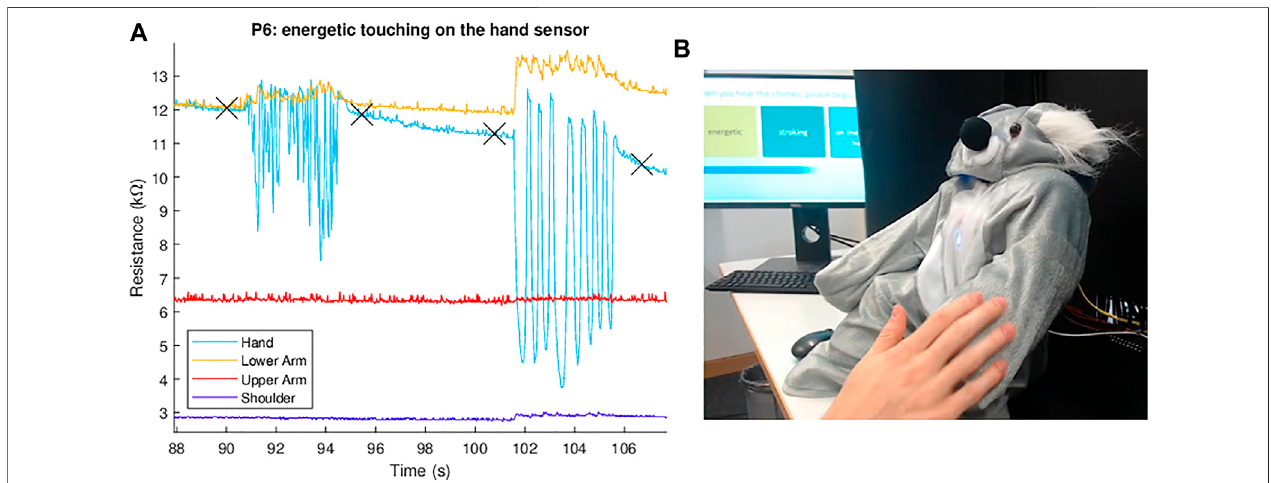
FIGURE3| Real-timesensorreadingsshowhowthefoursensorresistancevalueschange (A) astheparticipantinteractswiththerobot (B) .Thefour×symbolson the plot mark the experimenter ’ s timestamps. In this example, the participant performed an energetic tickling gesture on the robot ’ s hand between 90 and 96 s and performed energetic stroking on the same body part between 101 and 107